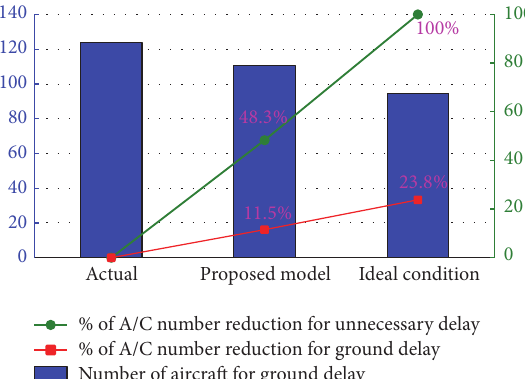
Figure 4: Benefits of the proposed model in terms of ground delay